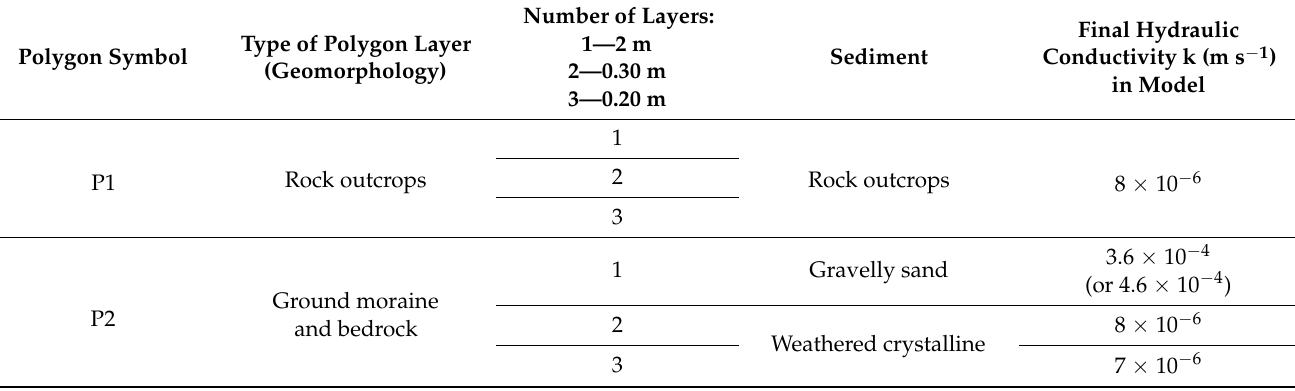
Table 2. Structure of the model layers and their final hydraulic conductivity. The five main sediment types represent the generalised result for the model layers within each type of geomorphological